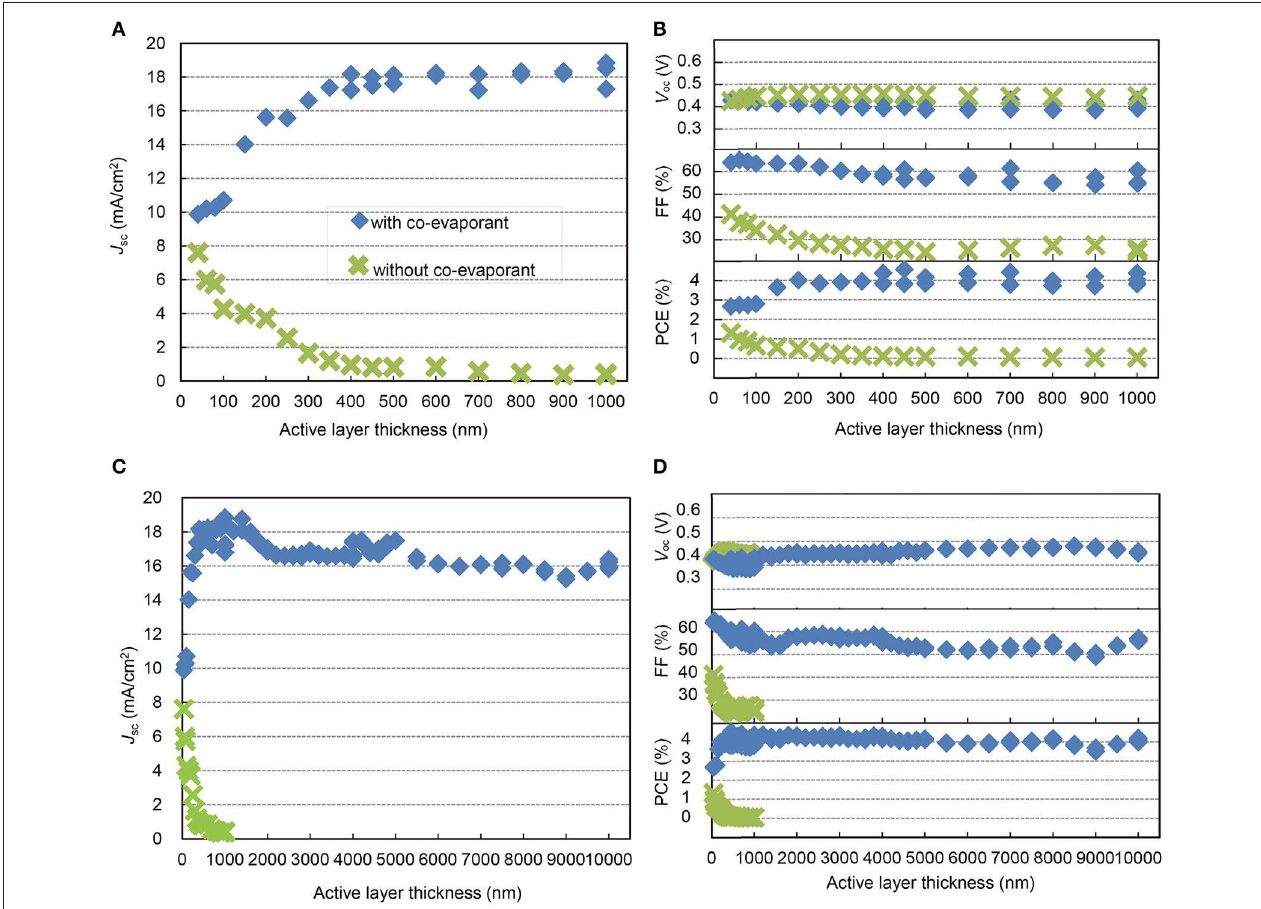
FIGURE 3 | Thickness-dependent properties of ZnPc:C 60 OPVs. J sc , (A,C) , V oc , FF, and PCE (B,D) of ZnPc:C 60 OPVs with each active layer thickness to 1 µ m (A,B) and 10 µ m (C,D) , with (blue square)/without (green cross) crystallization by the co-evaporant of PDMS.